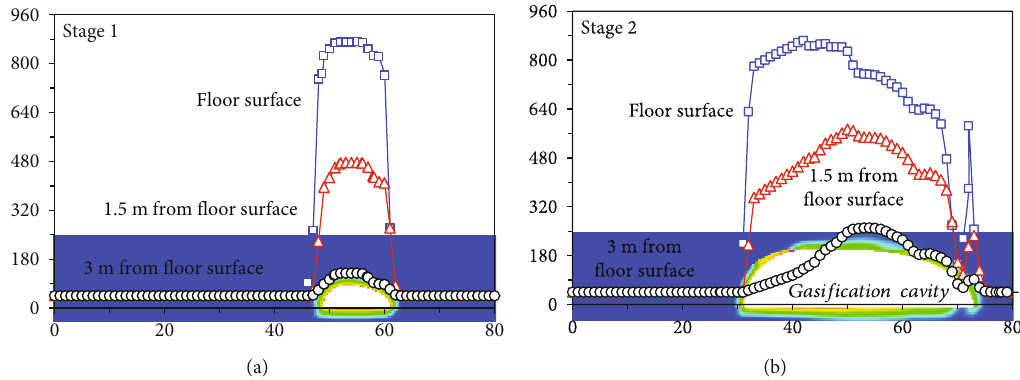
Figure 10: Temperature variation patterns at di ff erent depths of the coal seam fl oor: (a) stage 1 and (b) stage